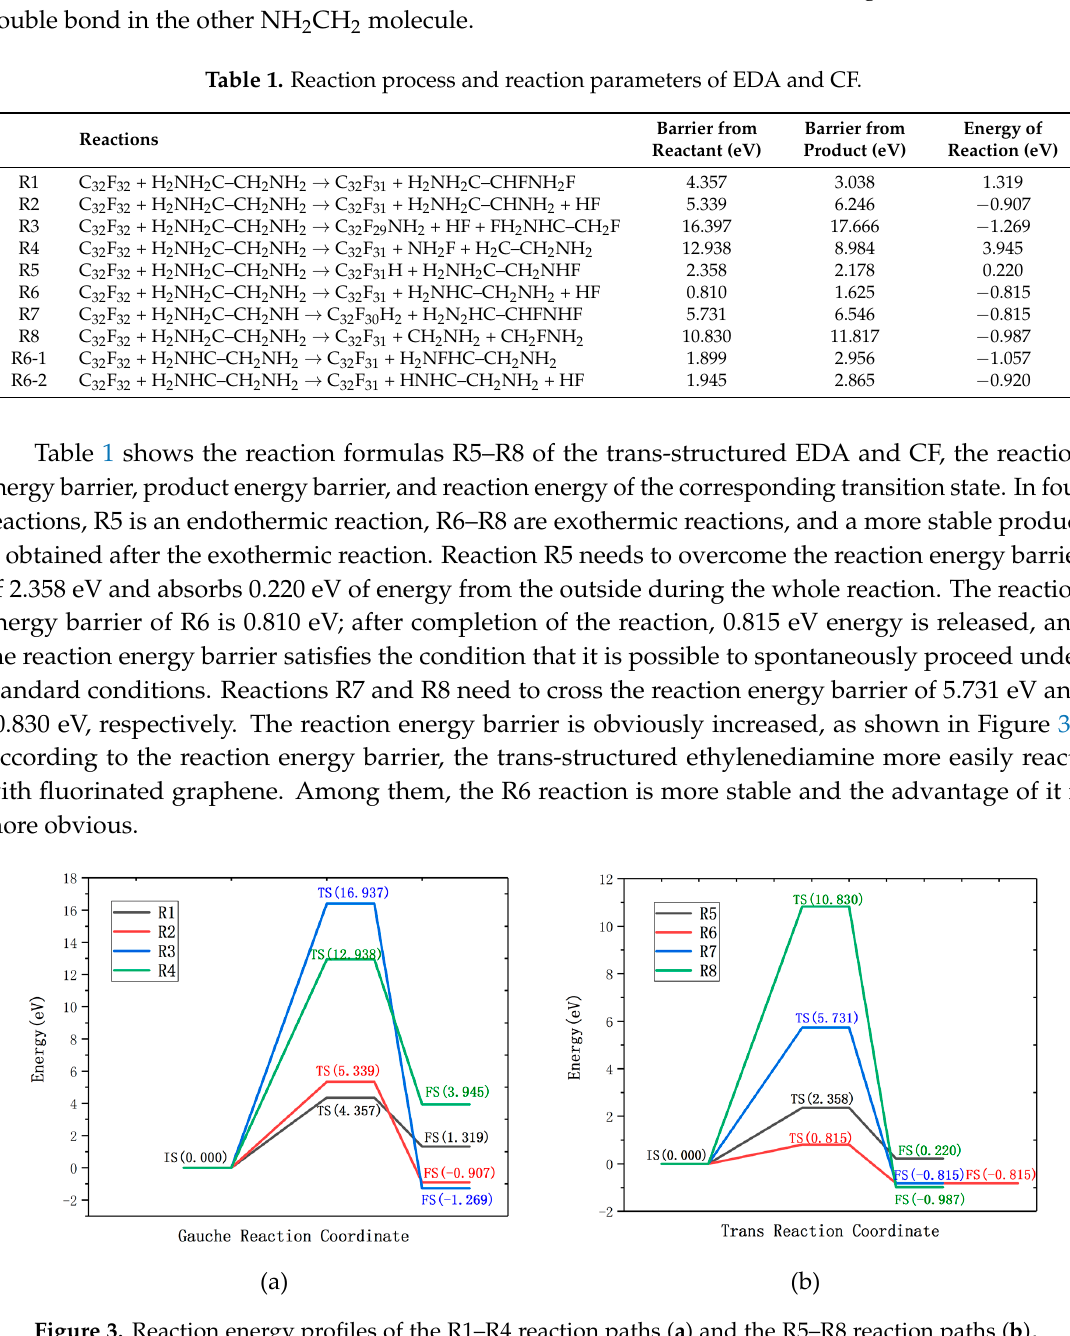
Table 1. Reaction process and reaction parameters of EDA and CF. Reactions